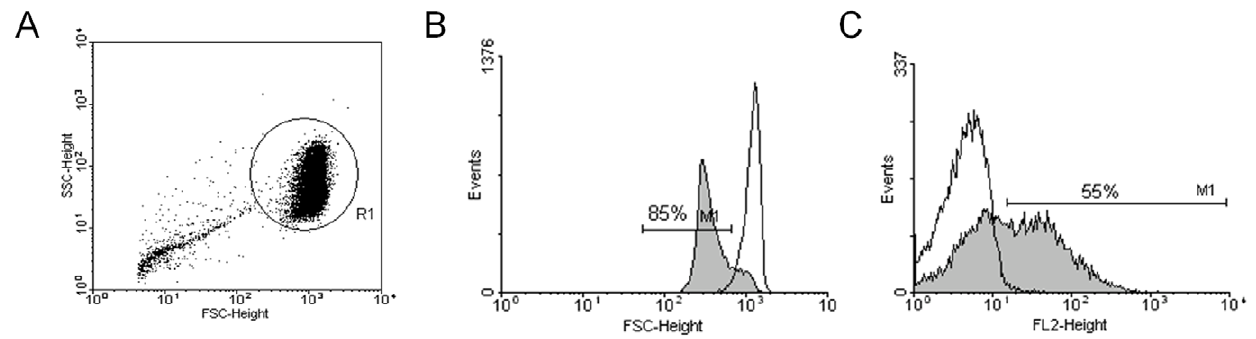
Figure 1. Induction of RBC eryptosis. RBC (A, R1) were incubated at 37 u C for 4 h at 2% hematocrit in presence (gray) or absence (black line) of ionomycin (1 m M) and, then, induction of eryptosis was verified by forward scatter measurement (B) and annexin V-PE staining